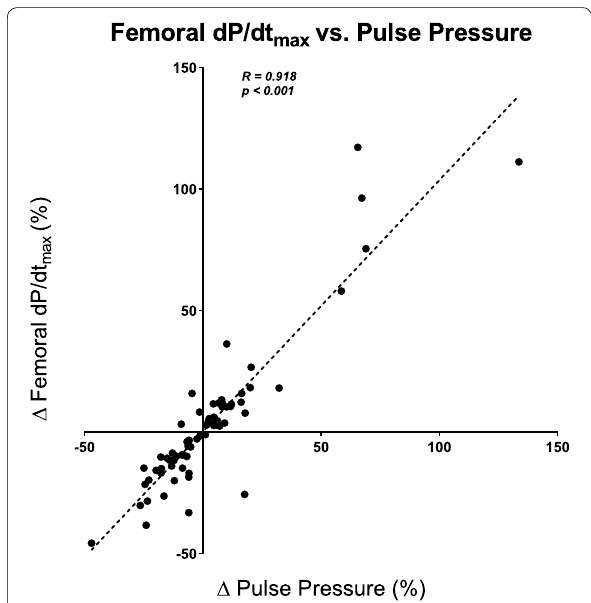
Fig. 2 Femoral d P /d t max versus pulse pressure. Correlation between femoral d P /d t max and pulse pressure (all interventions